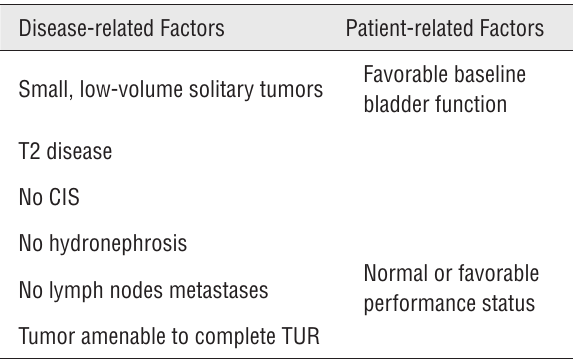
Table 1 - Bladder Preservation Patient Selection